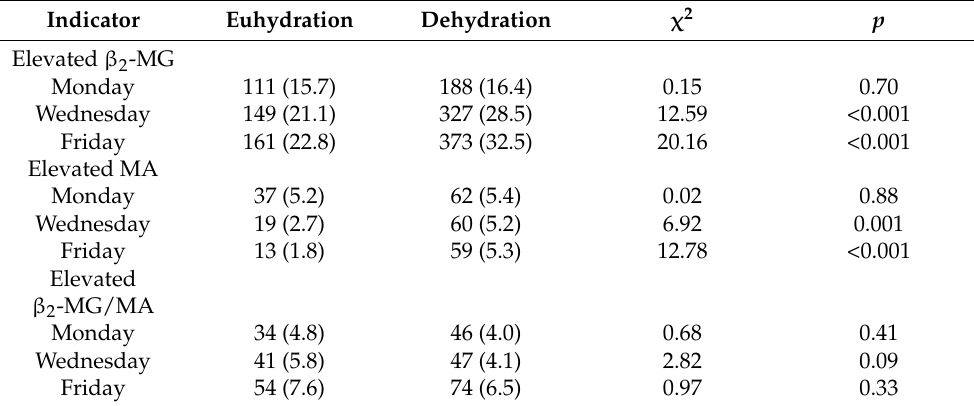
Table 3. Temporal trends of renal impairments by dehydration status over the school week in 7–8 years old children, Beijing, China ( N =